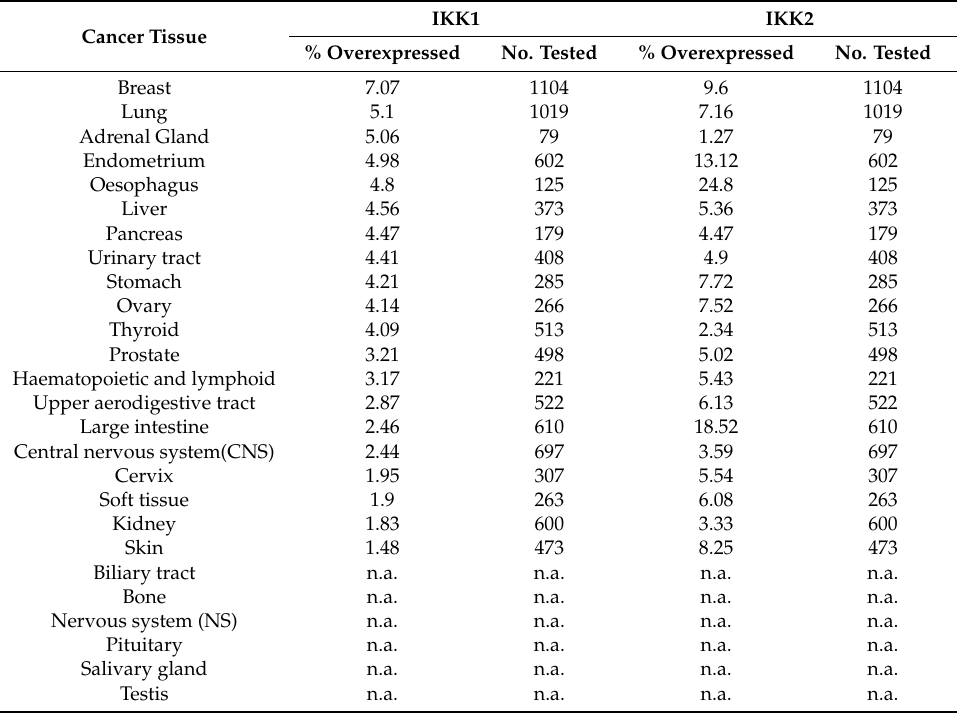
Table 2. Overexpression of I κ B kinases IKK1 and IKK2 in distinct human cancer tissues. COSMIC was used for database mining